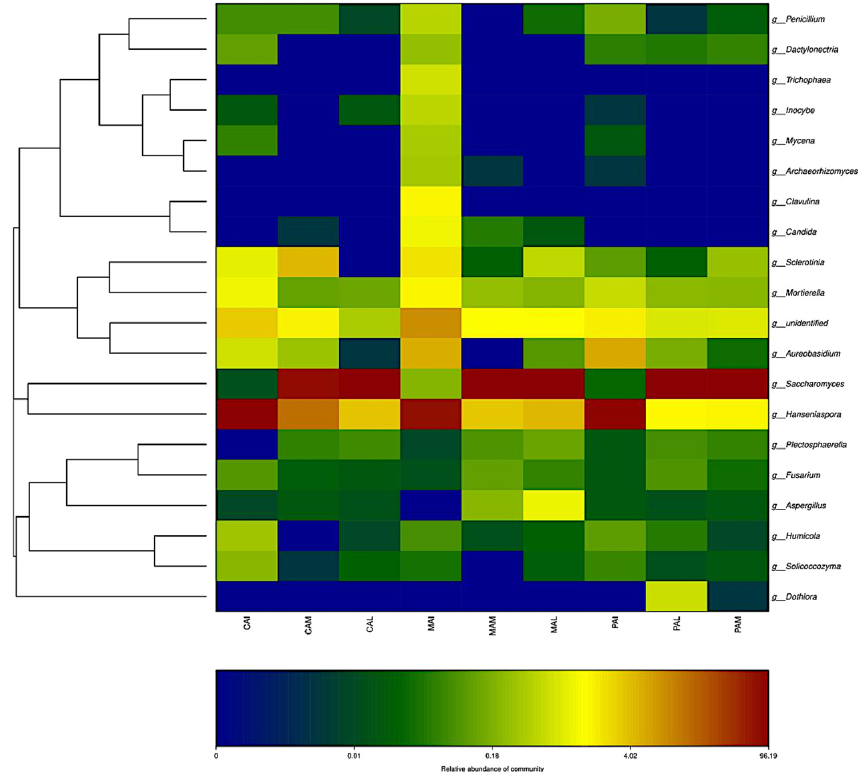
Figure 8. OUT and taxonomic level Heatmap. CAI is the pre-fermentation Cabernet Sauvignon, CAM